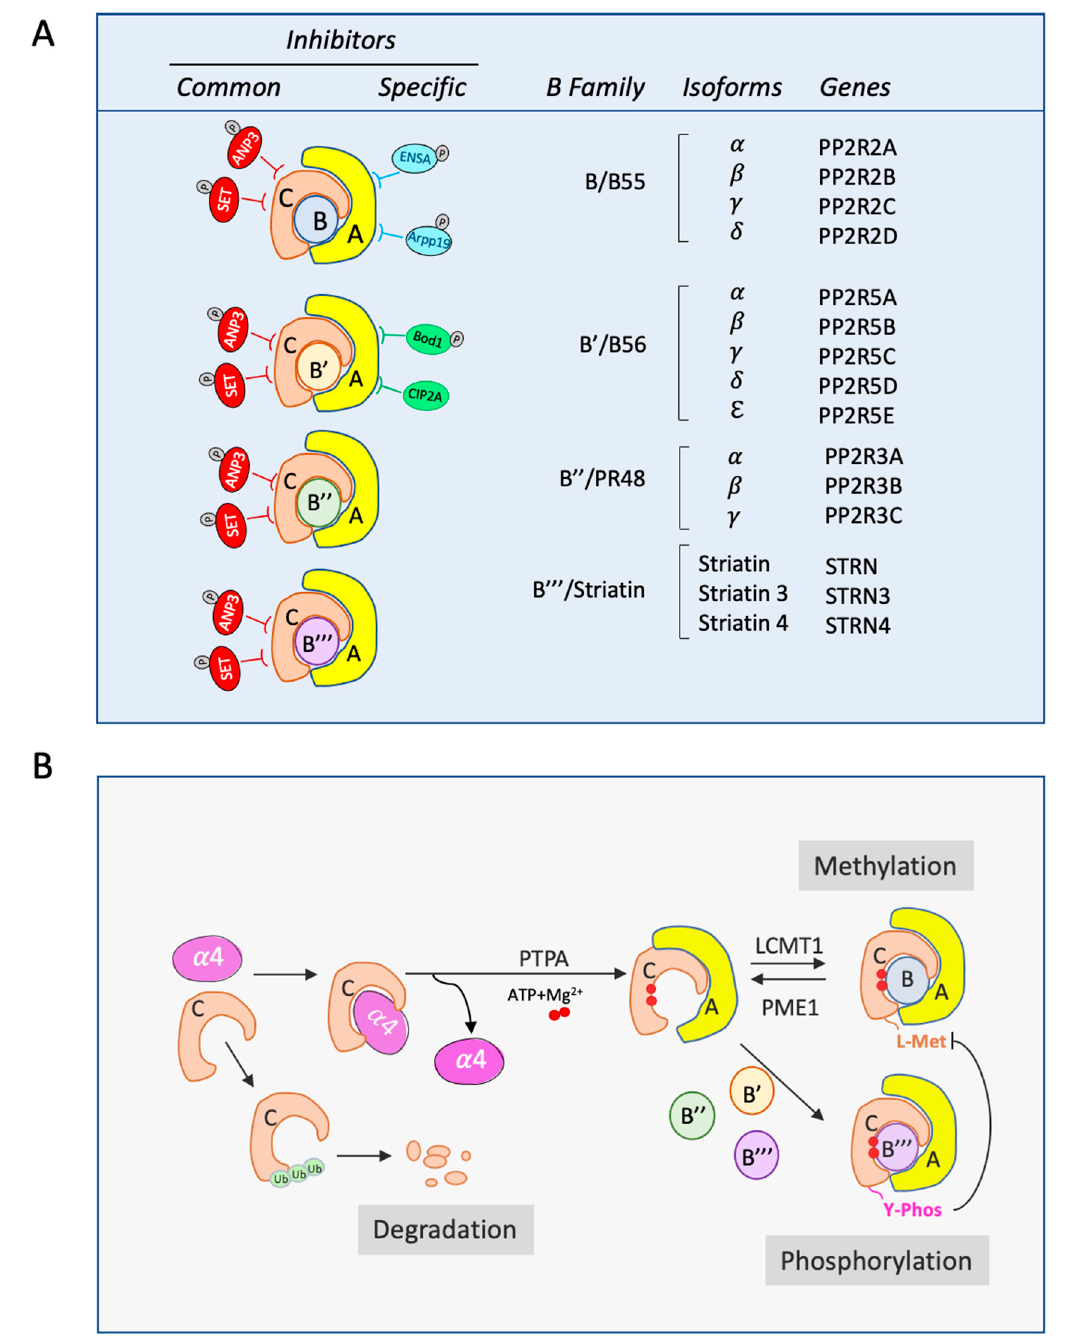
Figure 1. Composition and biogenesis of the PP2A holoenzymes. (A) Genes coding for the different isoforms of PP2A B subunits. Represented are also common and specific inhibitors of the PP2A holoenzymes. (B) Biogenesis of the PP2A complex. Monomeric C subunits binds α 4 protein or is directly ubiquitinated and degraded. C/ α 4 complex formation mediates A/C association that will be subsequently activated by PTPA by the introduction of Mg 2 + ions (red circles). This activation will permit the methylation or phosphorylation of the C subunit and the formation of PP2A-B55 or of the other holoenzymes respectively.